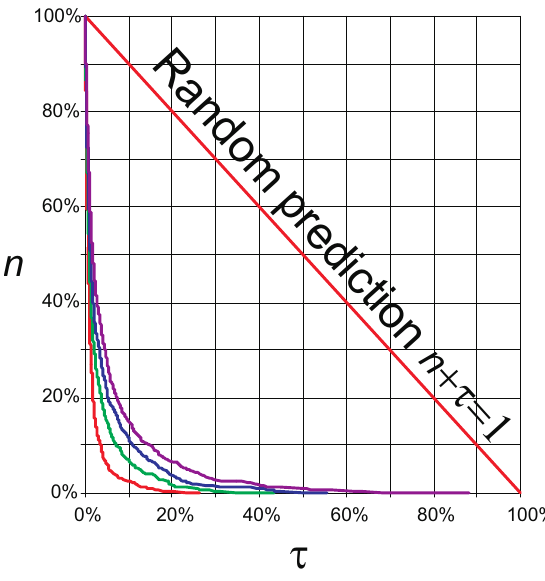
Fig. 14. Error diagram for PAF (hourly variation R ∗ computed from minute values) up to a 4-hour prediction (see text and Table 3). 1